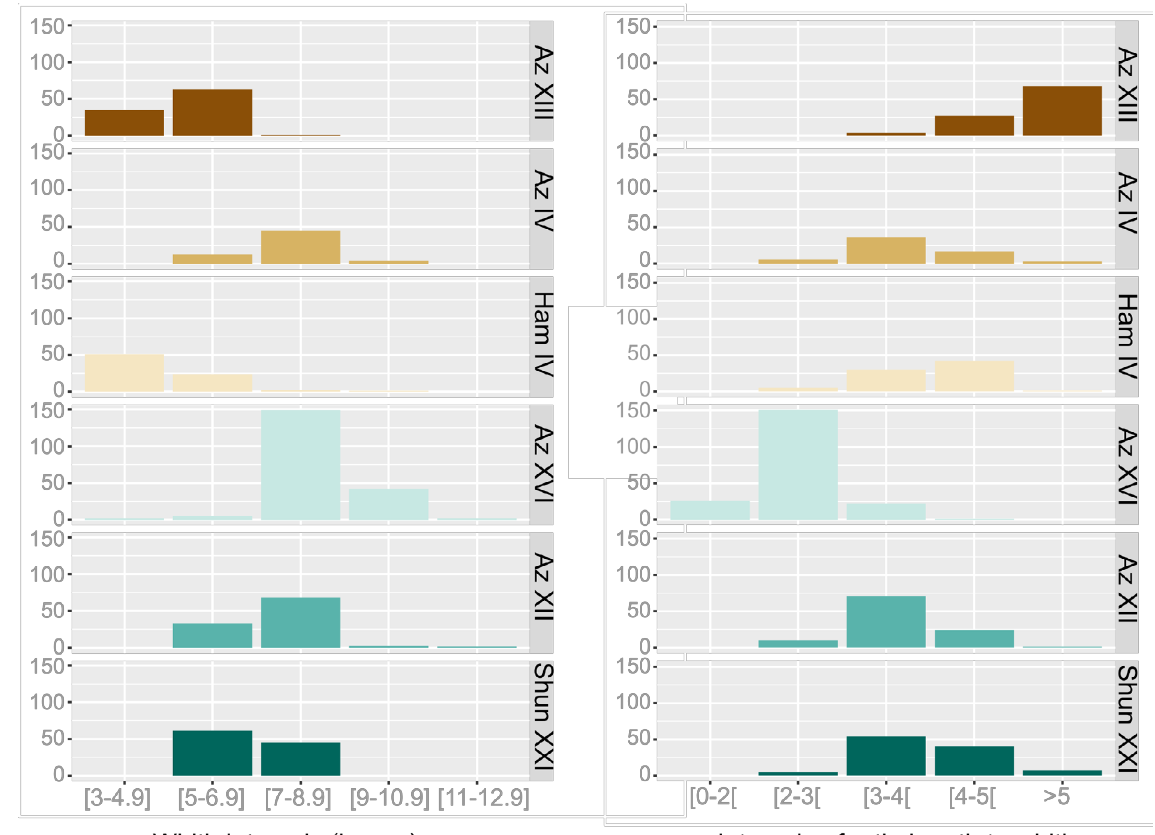
Figure 12. Comparisons of dimensions of retouched bladelets. Az - Azariq; Shun - Shunera; Ham -